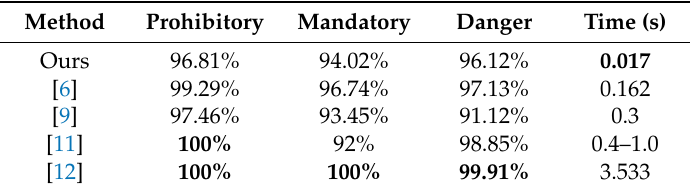
Table 6. The AUC values and processing